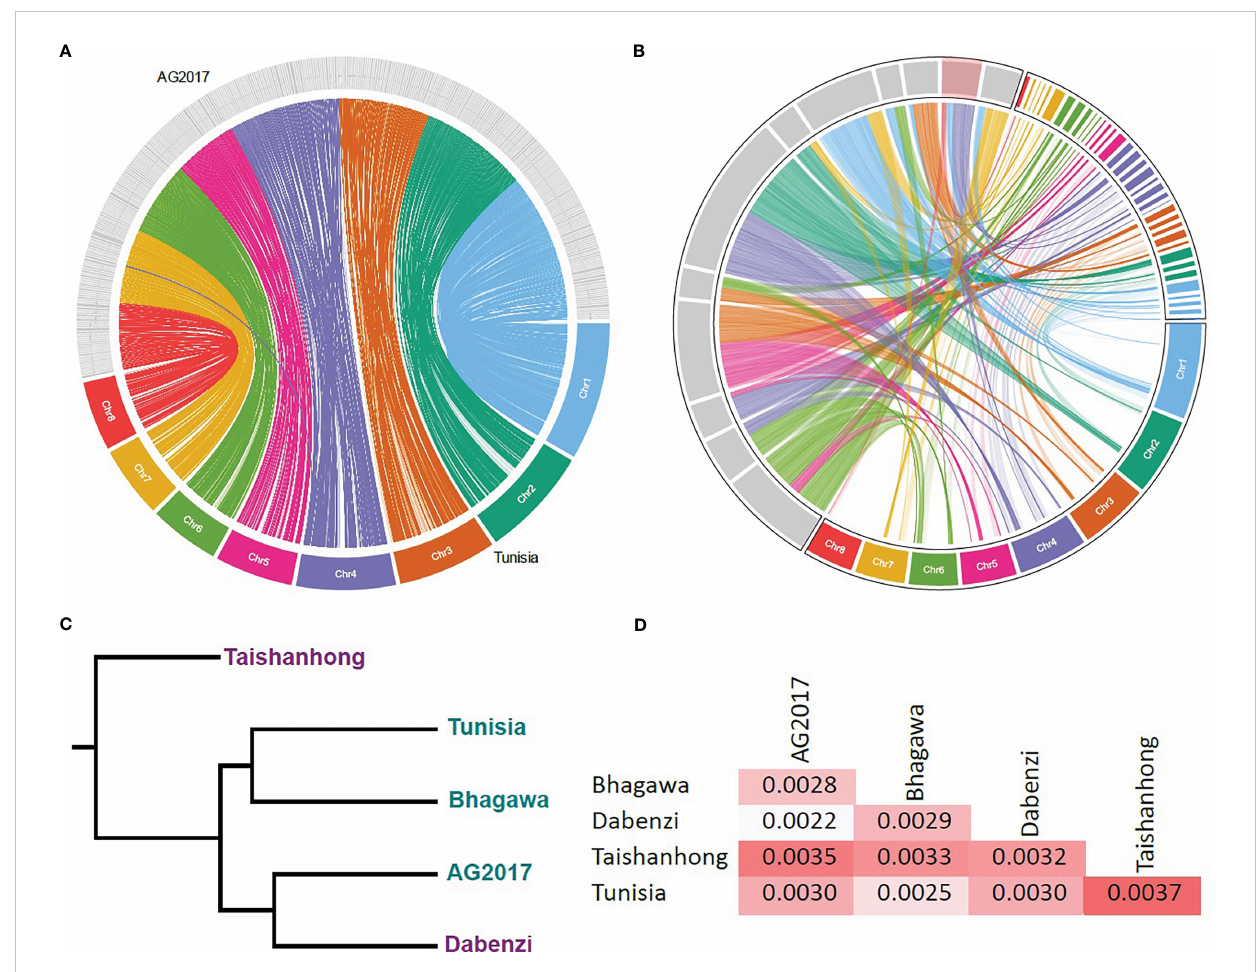
FIGURE 1 Comparative genomics of different de novo assembled genomes. (A) A circus plot showing the synteny between the Tunisia genome and the largest 400 scaffolds of the AG2017 genome; (B) the synteny between the Dabanzi and Tunisia genomes with 12 scaffolds of the Taishanhong genome that were aligned to different Tunisia chromosomes; highlighted red scaffold represents the scaffold MTJX01000087.1 which was aligned to three chromosomes; (C) whole-genome alignment-based phylogeny of the fi ve genomes; purple IDs represent the genomes with nine diploid chromosomes while blue IDs represent the genomes with eight diploid chromosomes; (D) maximum likelihood distance matrix between the fi ve